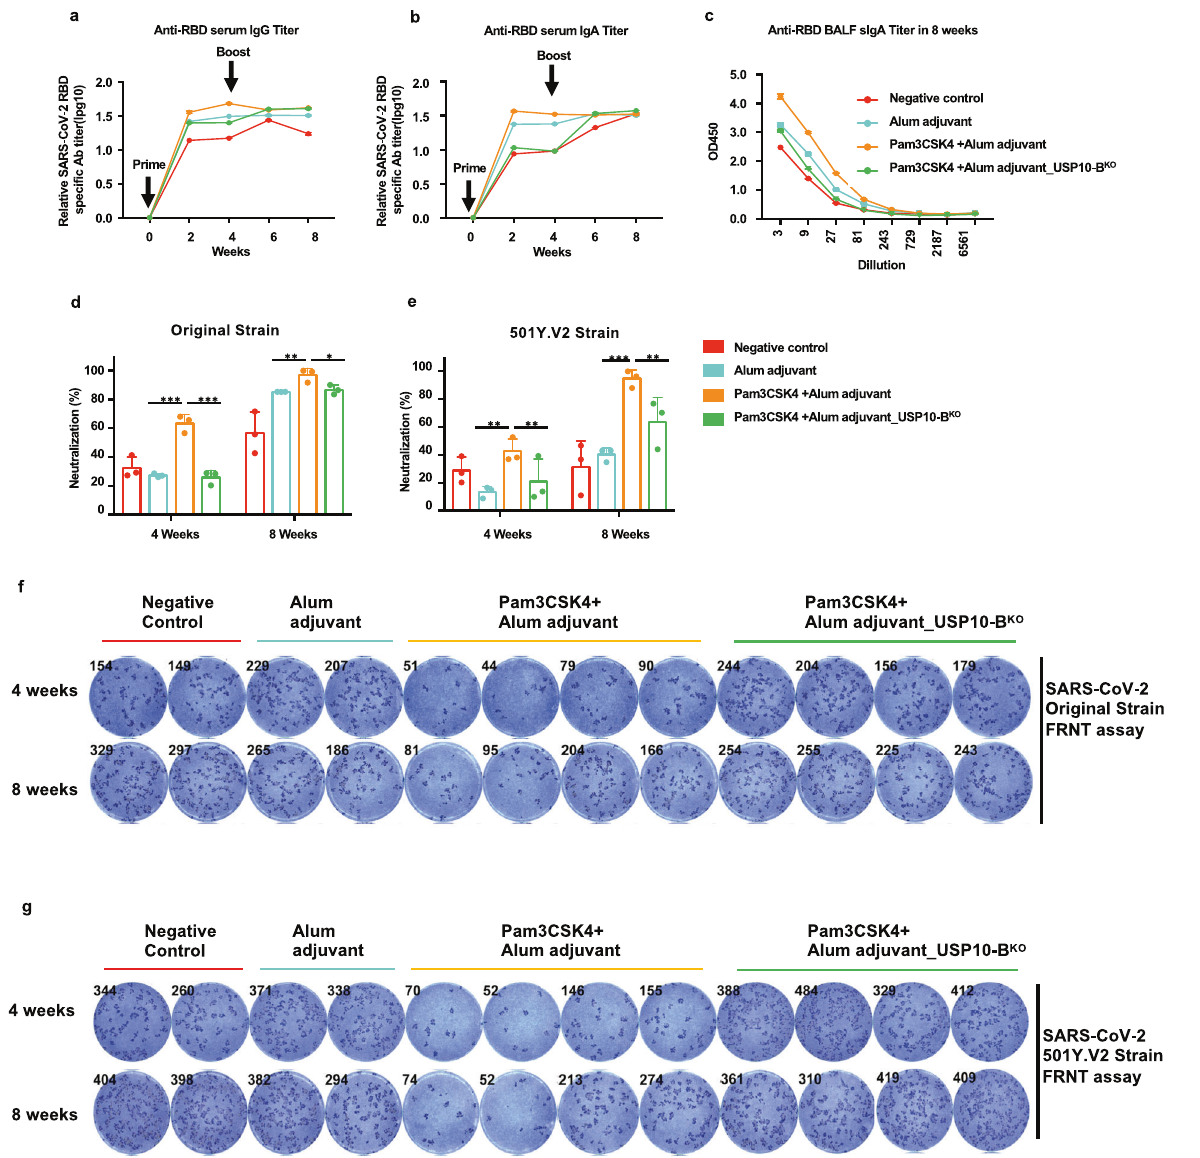
Fig. 7 Pam3CSK4 enhanced the antibody response to the SARS-CoV-2 RBD nanoparticle vaccine. The USP10-B WT , USP10-B KO mice were prime/boost-vaccinated with 5 ug of the SARS-CoV-2 RBD nanoparticle vaccines at week 0 and week 4. The Alum or Alum + Pam 3 CSK 4 is used as adjuvants. Serum was collected every 2 weeks. All mice were euthanized at week 10. a , b The RBD-speci fi c IgG, IgA relative titers at each week were plotted as a time-course curve. c The bronchoalveolar lavage fl uid (BALF) was collected from euthanized mice in week 10. RBD- speci fi c sIgA titers plotted as OD value versus dilution factors. d , e The neutralization of sera in immunized mice was detected with pseudotyped-SARS-CoV-2 original strains and 501Y.V2 strains. The neutralizations at dilution of 1:200 of serum were shown. f , g The serum neutralization to authentic SARS-CoV-2 of each vaccine group was determined by FRNT assay with anti-SARS-CoV-2 N protein antibody staining. The SARS-CoV-2 original strain and 501Y.V2 strain were separately used. The representatives of FRNT spot wells within 1:20, 1:200, or 1:2000 dilution groups were